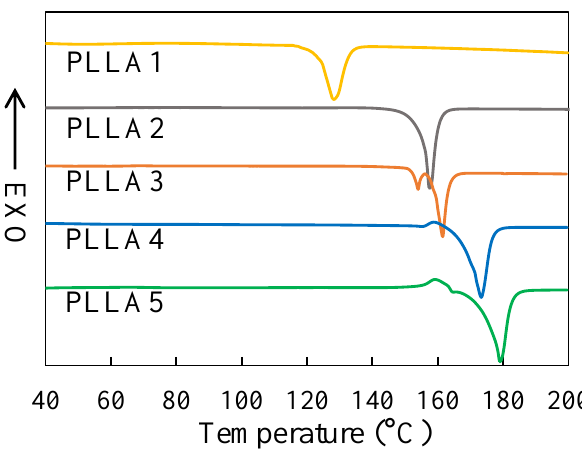
Figure 5. DSC melting curves of PLLA samples after isothermal crystallization at 80 °C. The exothermal direction is marked on the Y -axis.